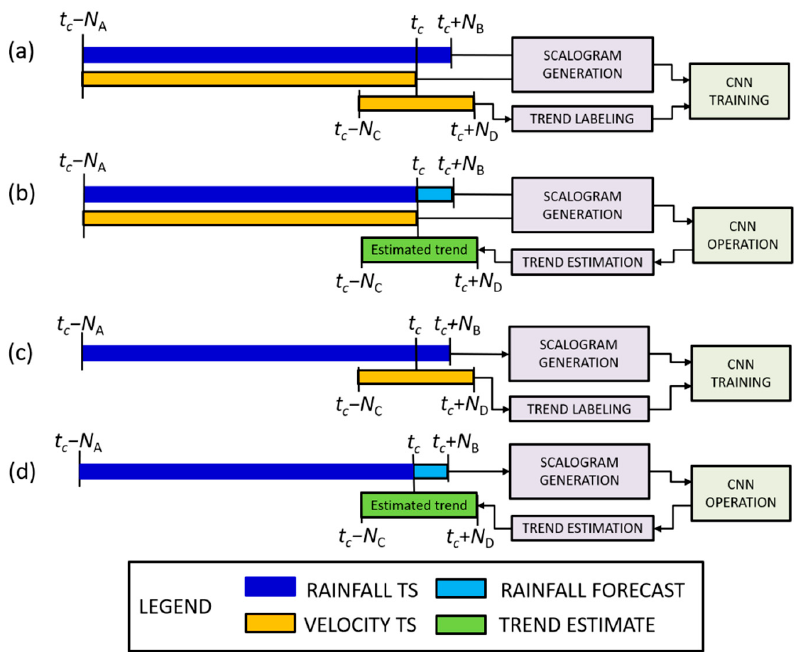
Figure 4. Schema of the use of input time series (TS) for the CNN training and operation for a computation time t c : ( a ) training with both rainfall and velocity data, where velocity data are used for both scalogram computation and trend labeling; ( b ) corresponding operation, where weather forecasts are also used; ( c ) training with rainfall data only, where velocity data are used for trend labeling only; ( d ) corresponding operation.